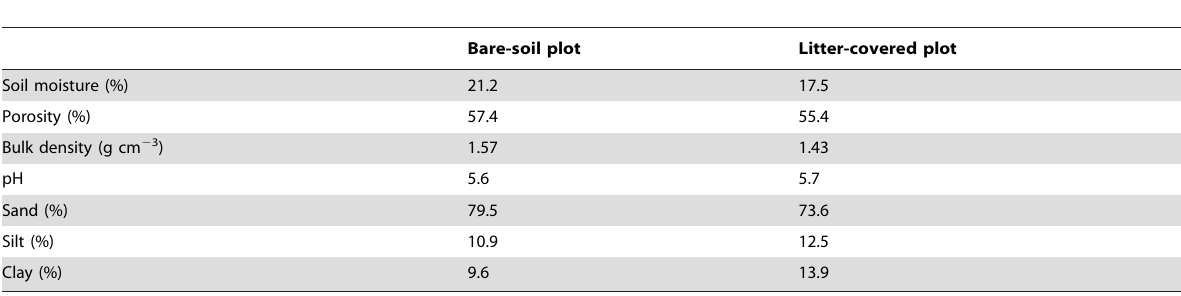
Table 2. Soil properties (0–40 cm deep) in experimental and control plots.